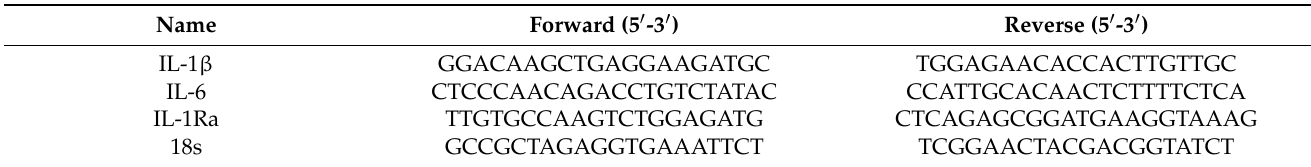
Table 1. Primers used in